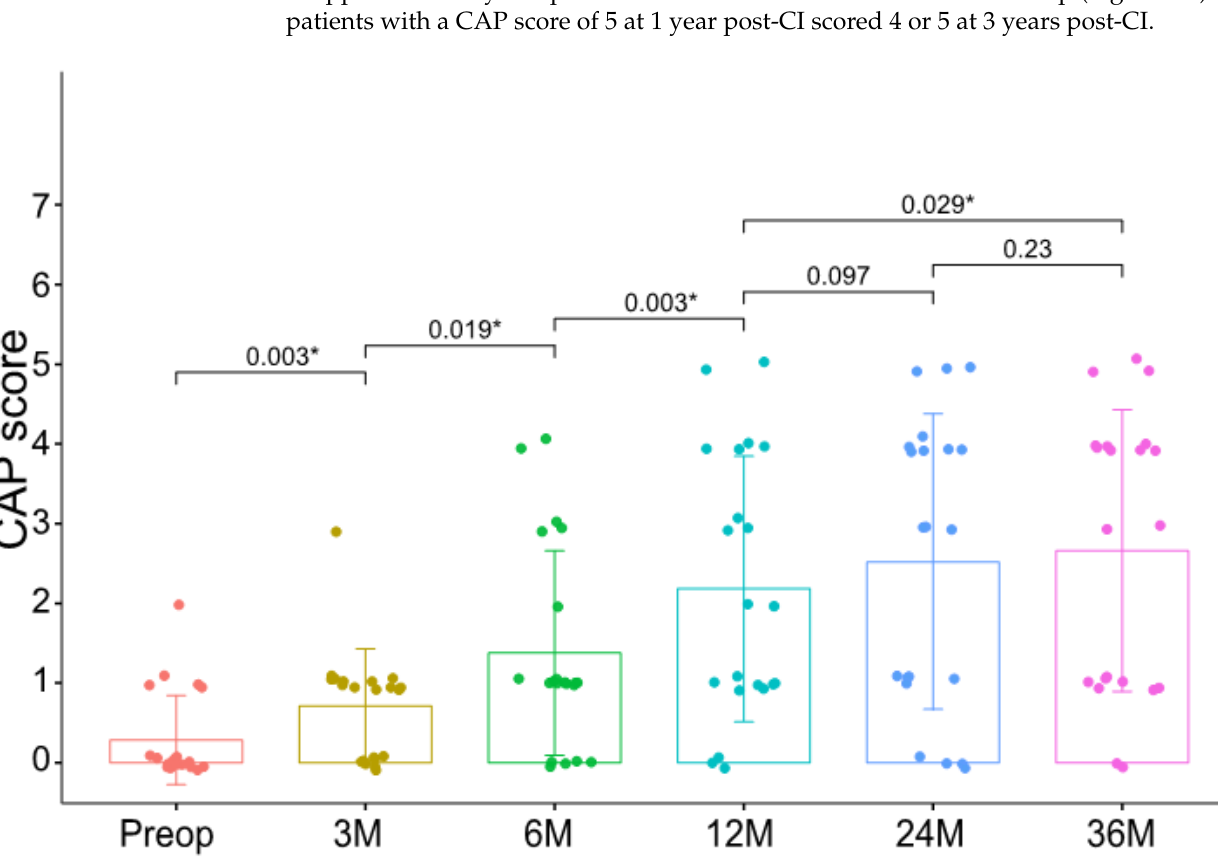
Figure 2. Preoperative and postoperative CAP scores in pediatric cochlear implantees with bilateral cochlear nerve deficiency. p -values are presented on the comparing lines. *, statistical significance (by Wilcoxon signed-rank test). CAP, Category of Auditory Performance; Preop, preoperative; M, postoperative months.